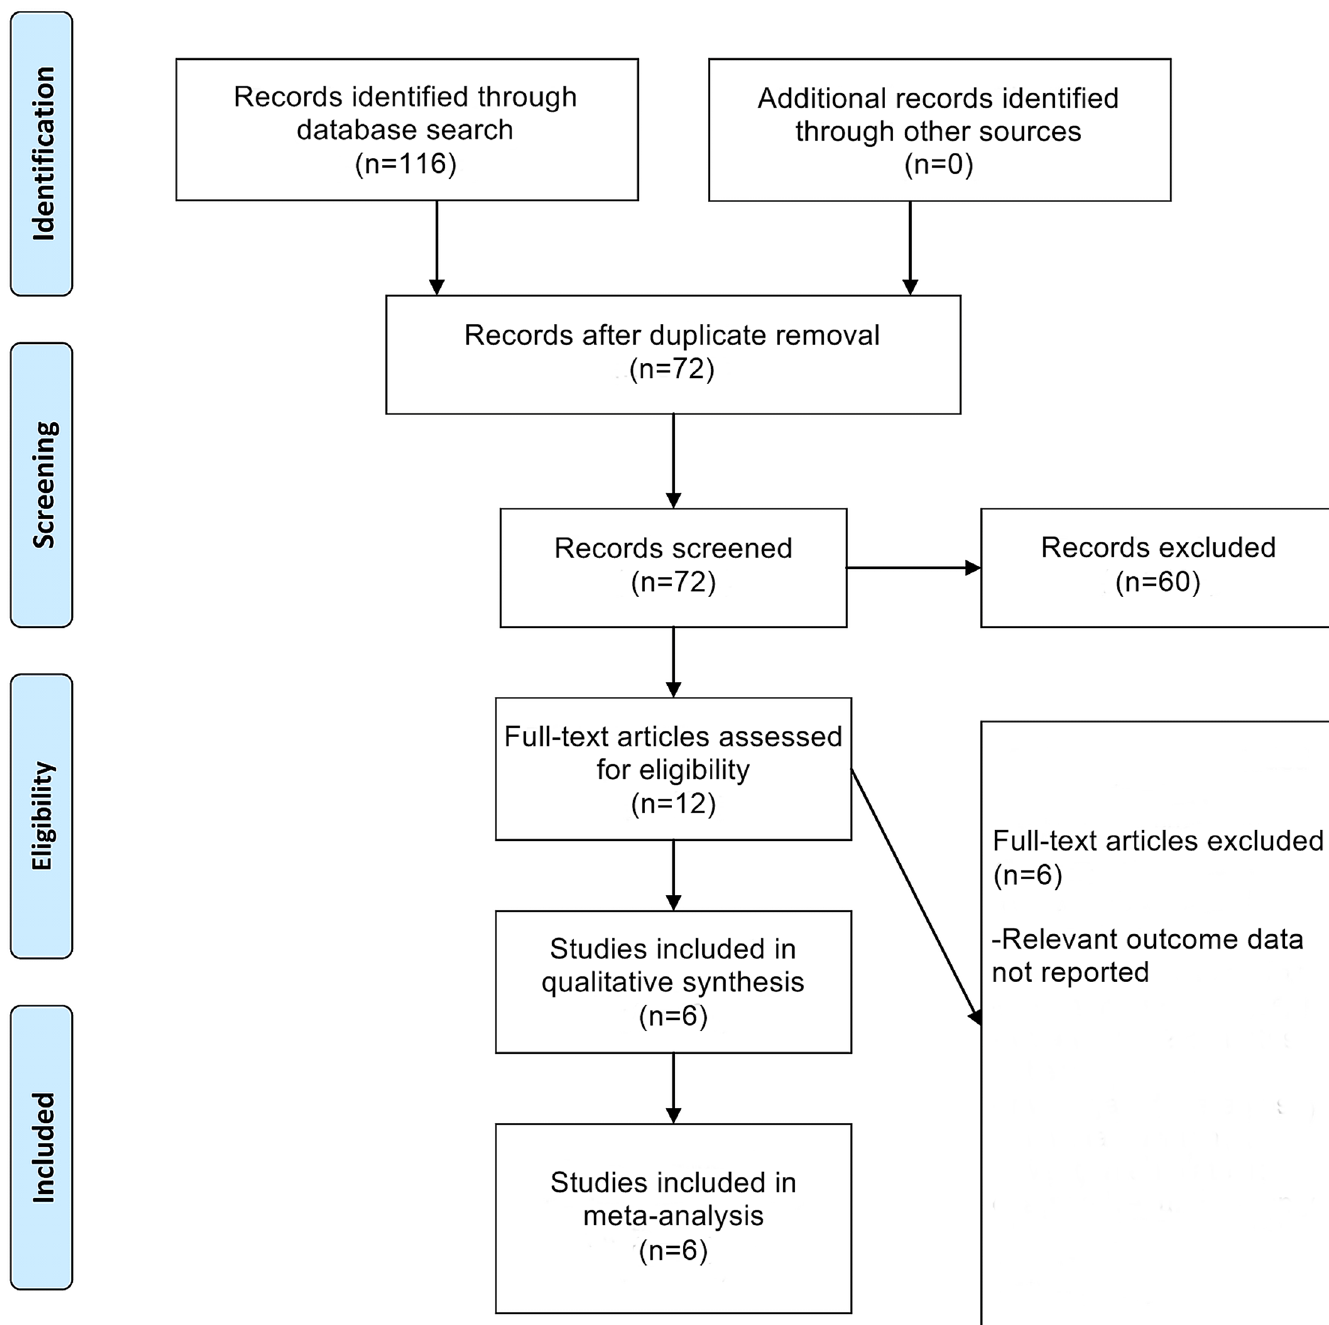
Fig 1. Flowchart of Study